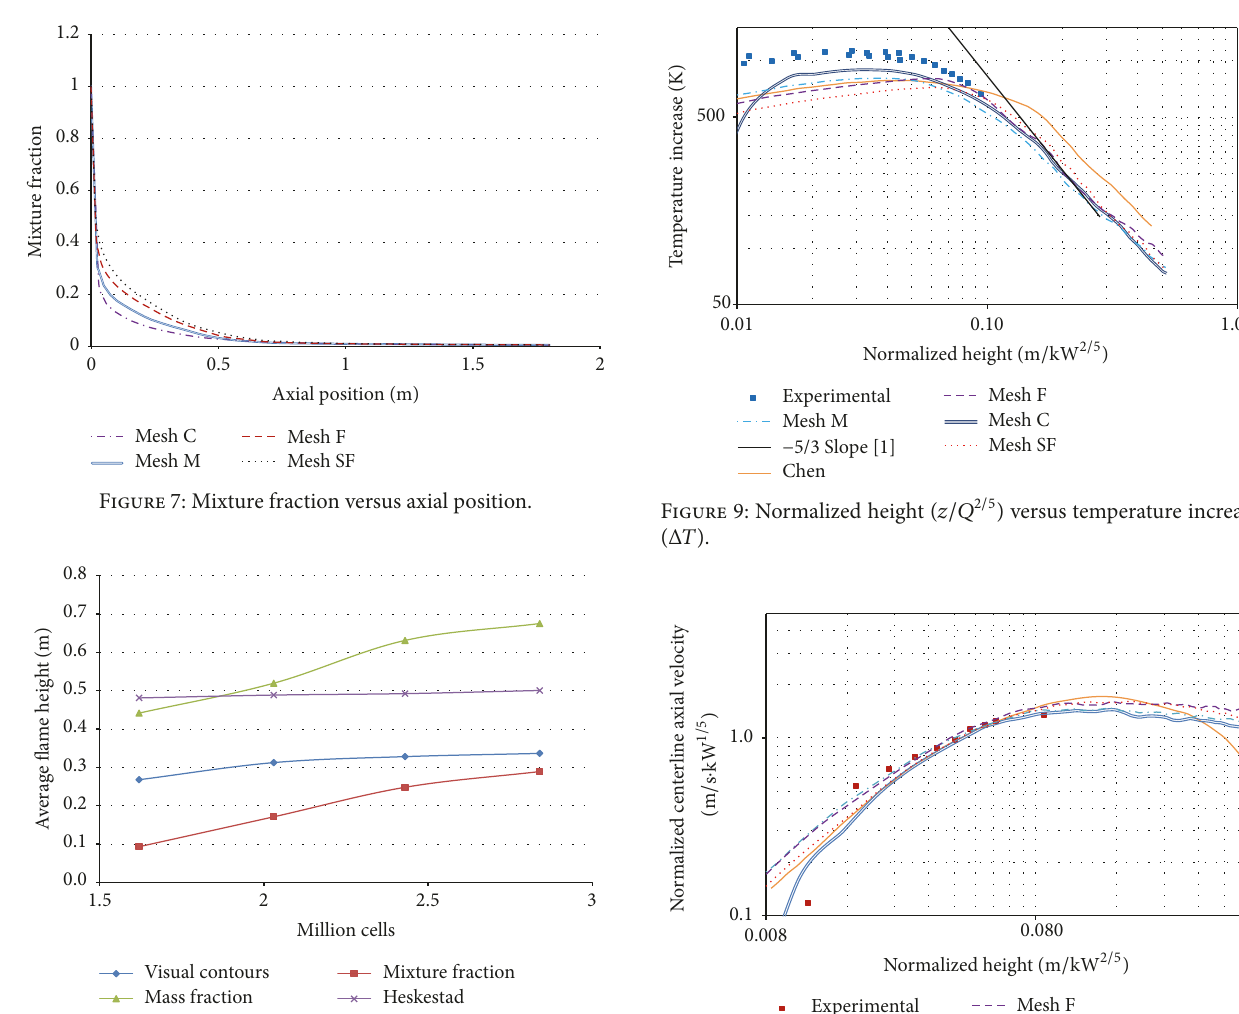
Visual contours Mixture fraction Mass fraction Figure 8: Mesh convergence.